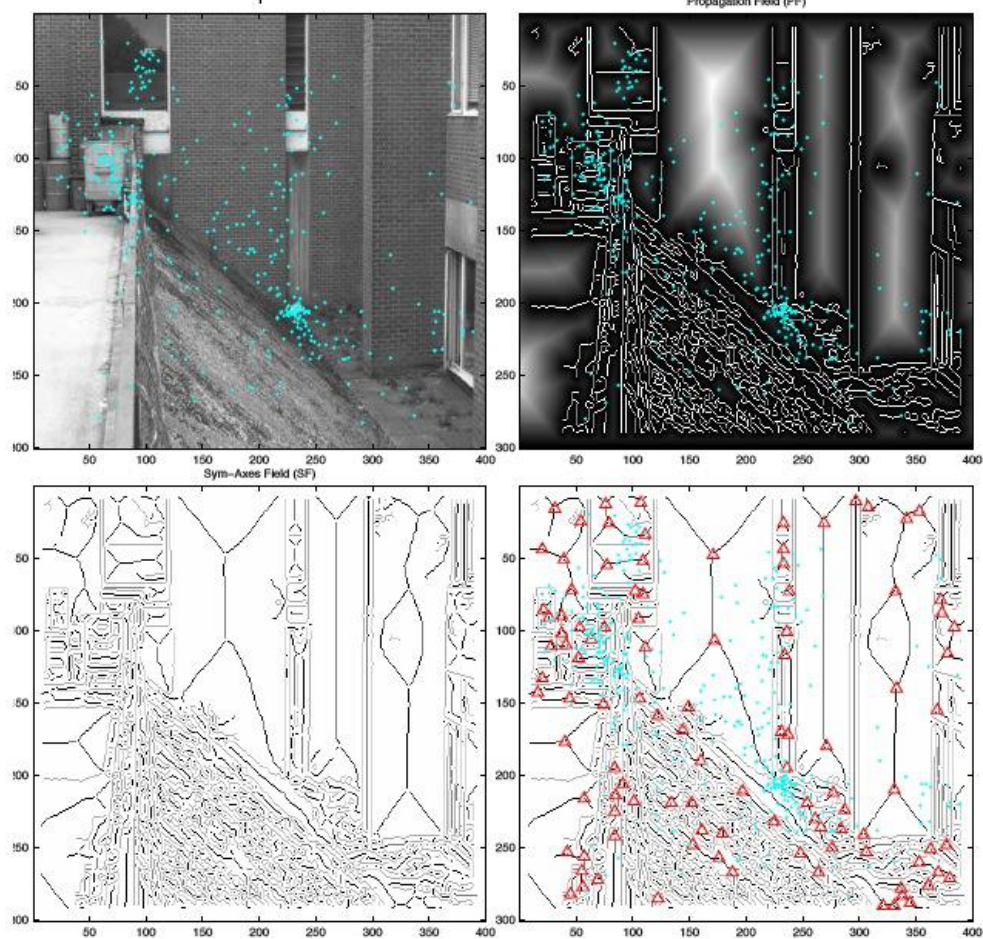
Figure 2. Example of a symmetric-axis transformation of a contour image (cyan dots denote fixation locations for 22 subjects for the first 5 seconds of viewing; image taken at 3 rd scale (I 3 ). Upper right: Distance mapwith symmetric axes already visible as veins in the regions (contours in white; regions are bright). Lower left: Contours (gray) and symmetric axes (black), respectively. Lower right: Intersections of sym-axes segments marked with red plus